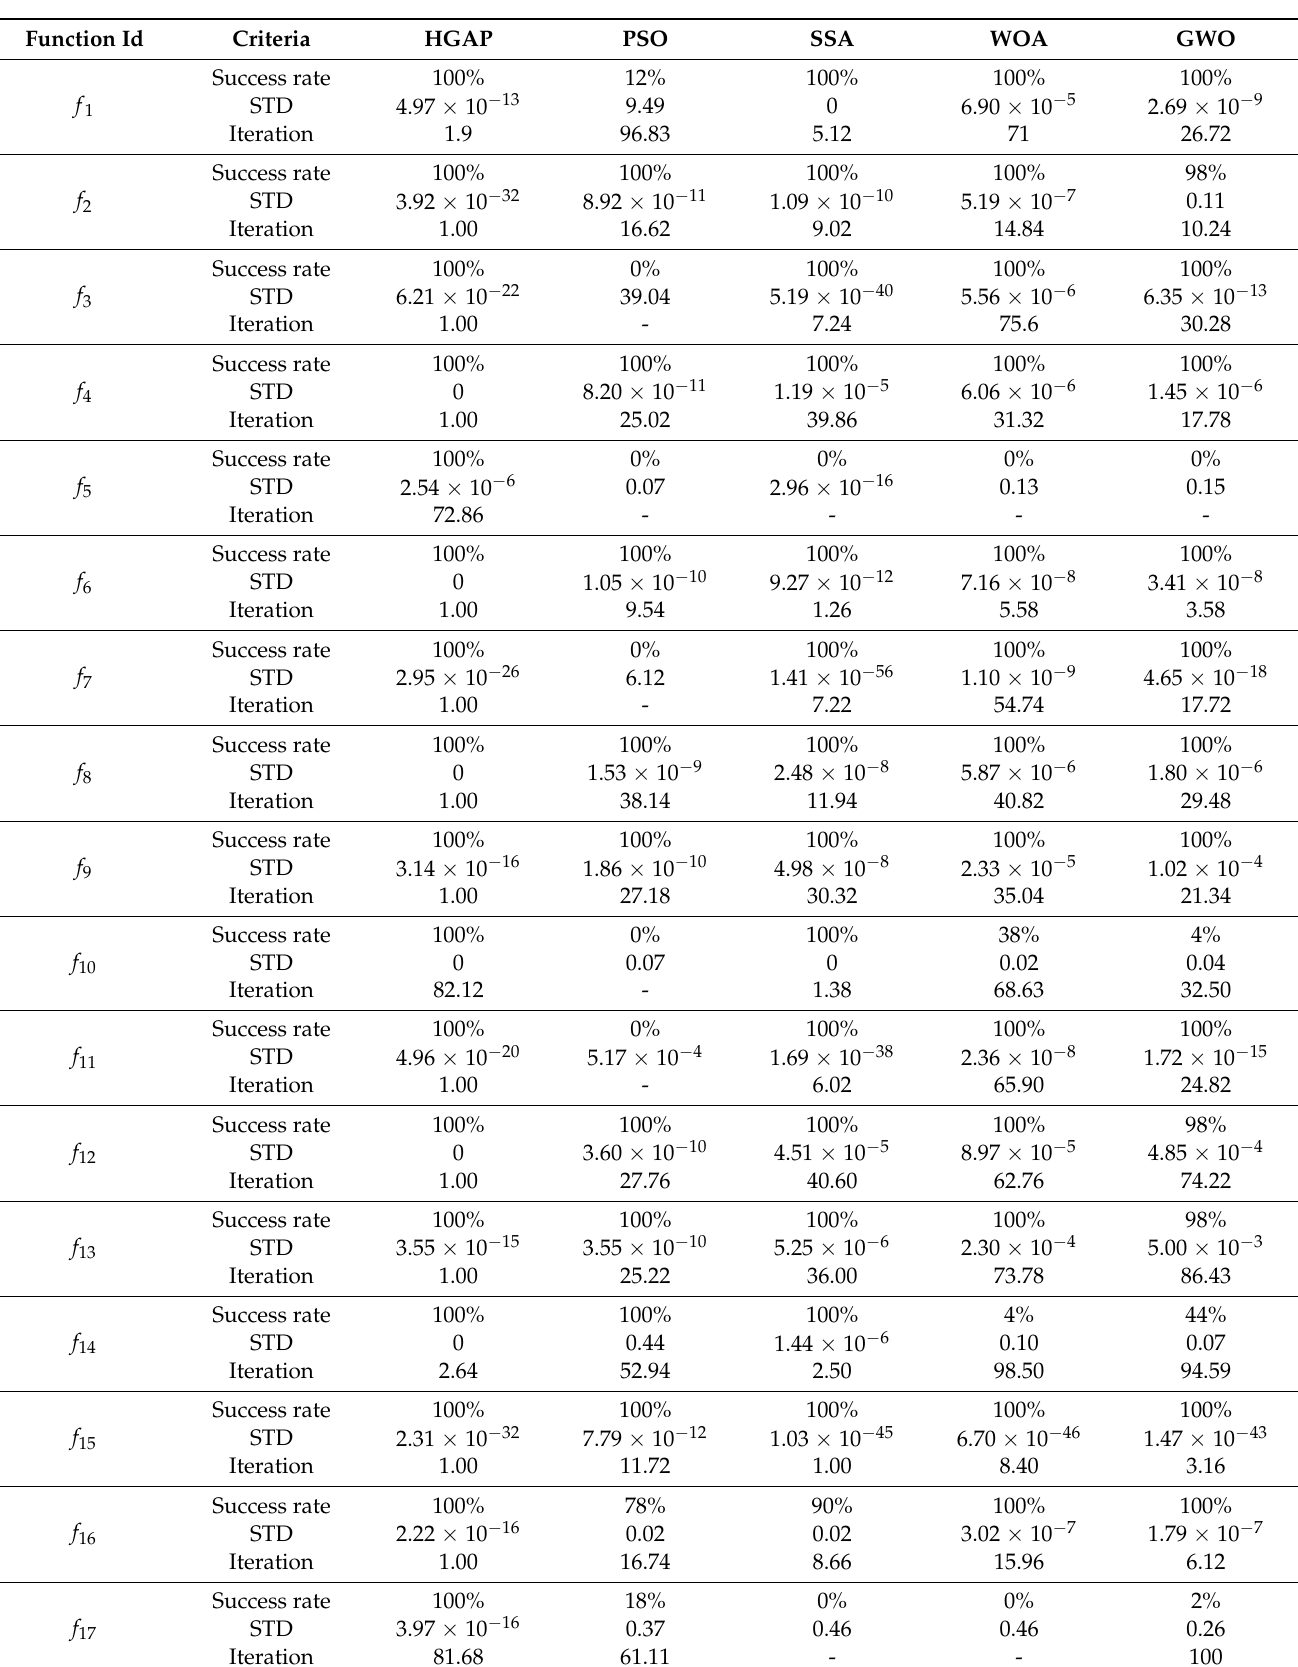
Table 2. The results of the Benchmark functions